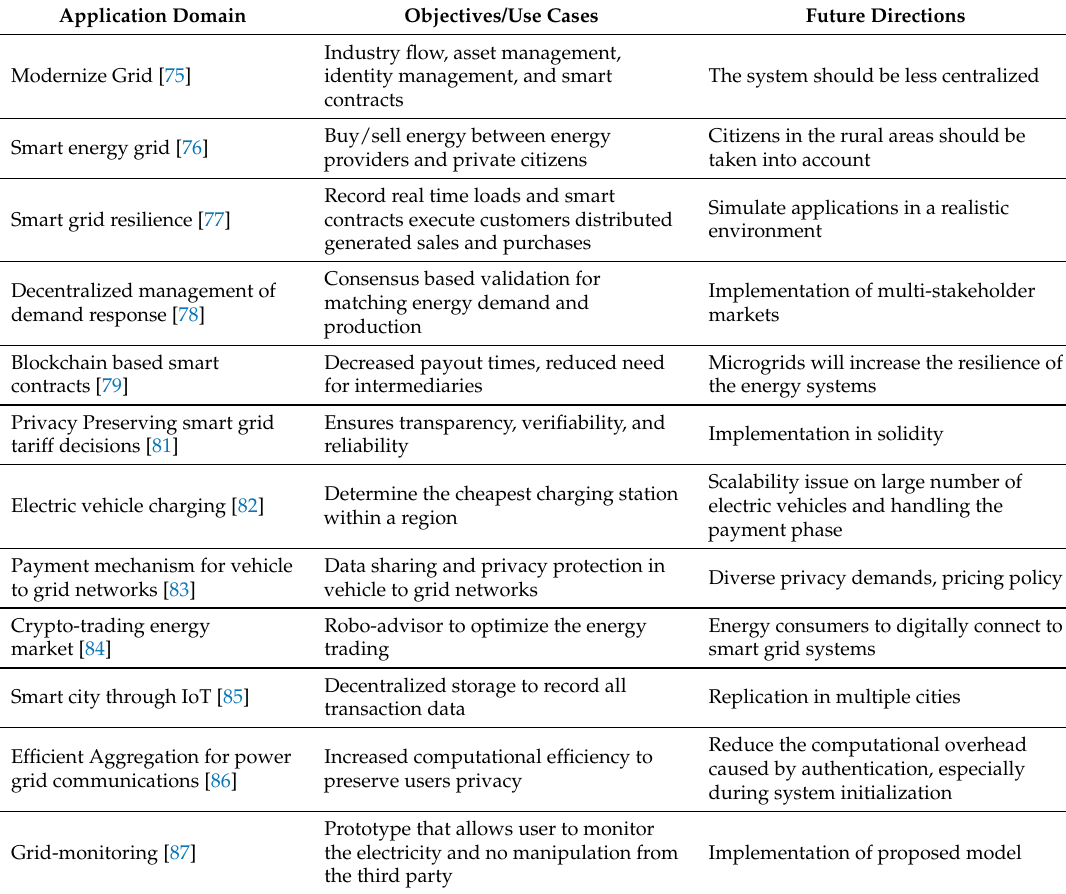
Table 5. Use cases, design challenges, and future directions in smart grid